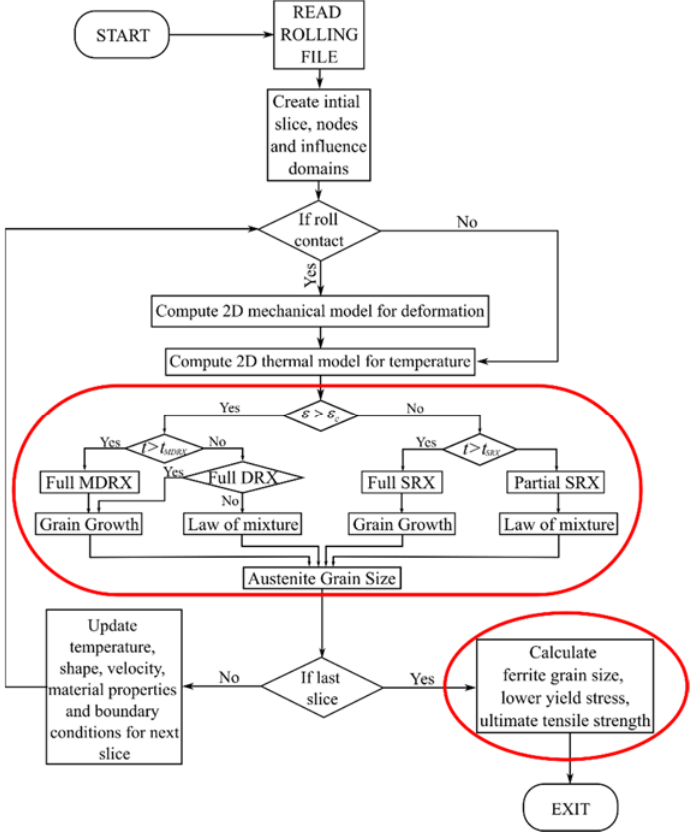
Figure 5. Scheme of the multiscale rolling simulation system. Micro-scale simulation steps are circled with red.